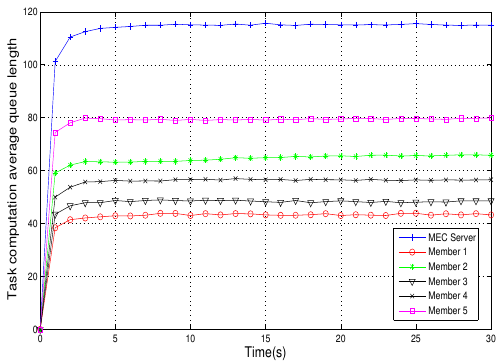
Figure 8. Task computation average queue length vs.